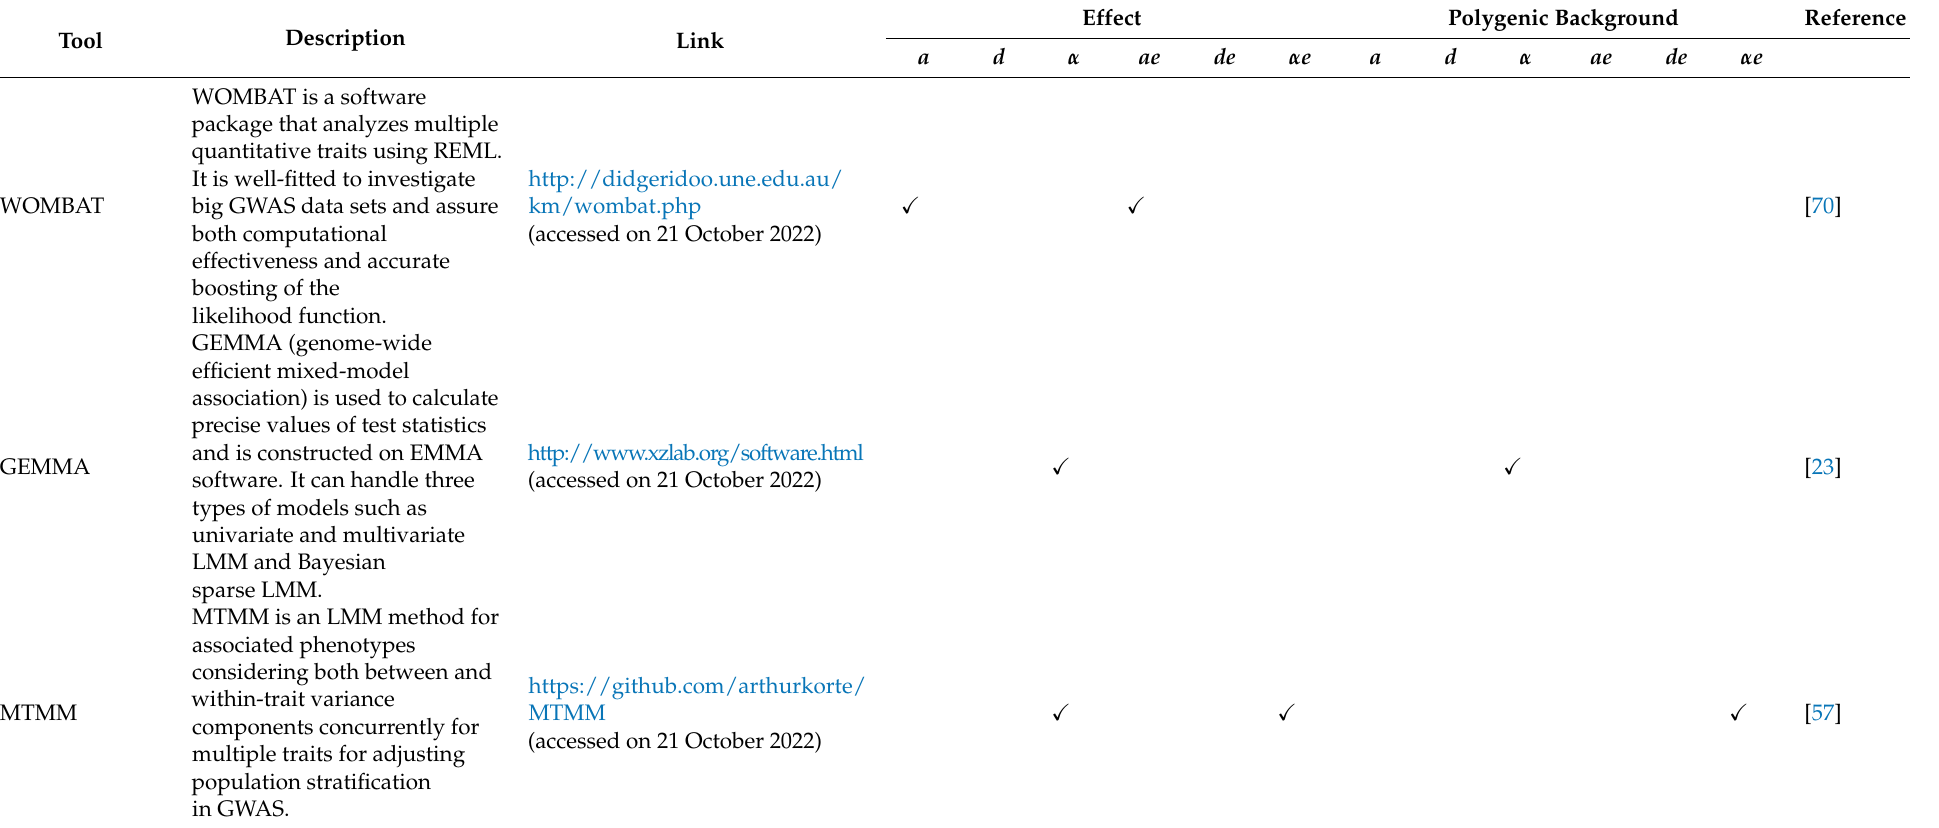
Table 3. Multi-trait/multivariate models and their respective software and packages using LMM. Tool Description